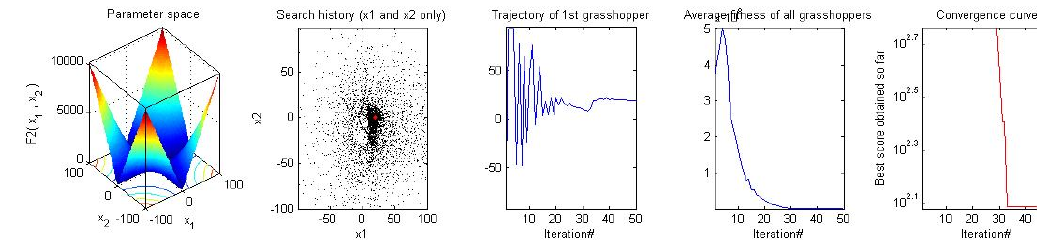
Figure 3. HAGOA search behavior on unimodal function (F2)